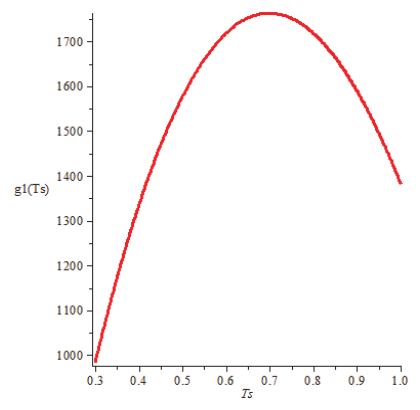
Fig. 3. Concavity of total cost saving Fig. 4. Concavity of total cost